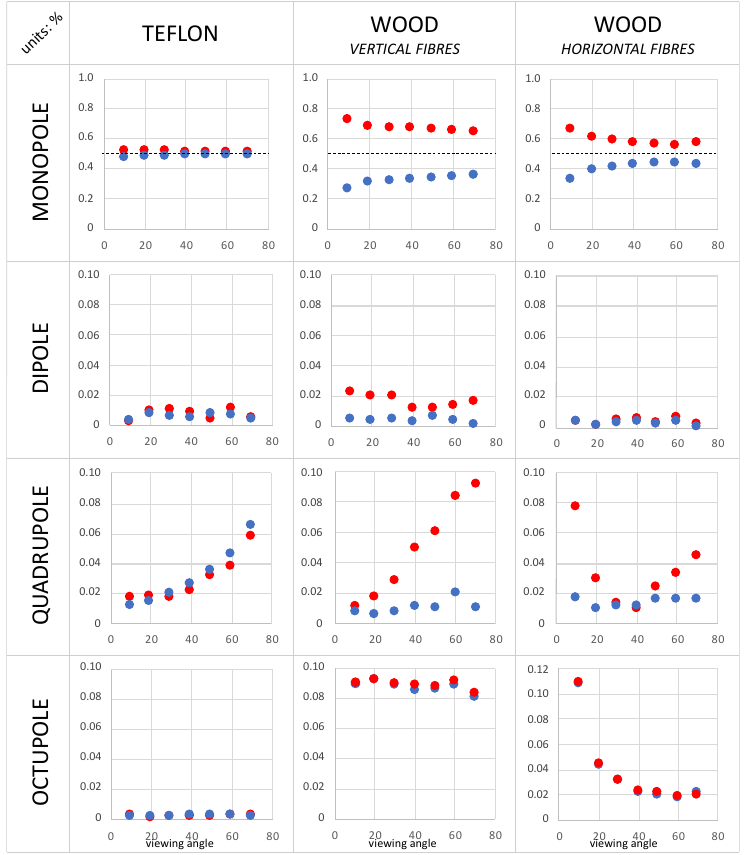
Figure 6. Multi-pole analysis of the obtained polar signals shown in Figures 4 and 5. The octupole contribution is null for the isotropic sample (Teflon) while in wood it shows high values. The vertical orientation of the fibres gives a contribution of octupole independent of the viewing angle while, for the horizontal orientation of the fibres, the emission efficiency of the octupole terms decreases as the angle of observation increases. Monopole, quadrupole and octupole radiance contributions are indeed discriminat- ing factors to recognize the orientation of the material texture. Monopole and quadrupole emissions are polarisation sensitive while octupole seems to be perfectly depolarised.